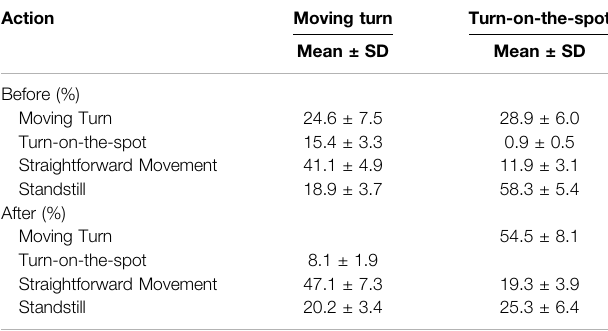
TABLE 5 | Identi fi ed action 1 s before and after a